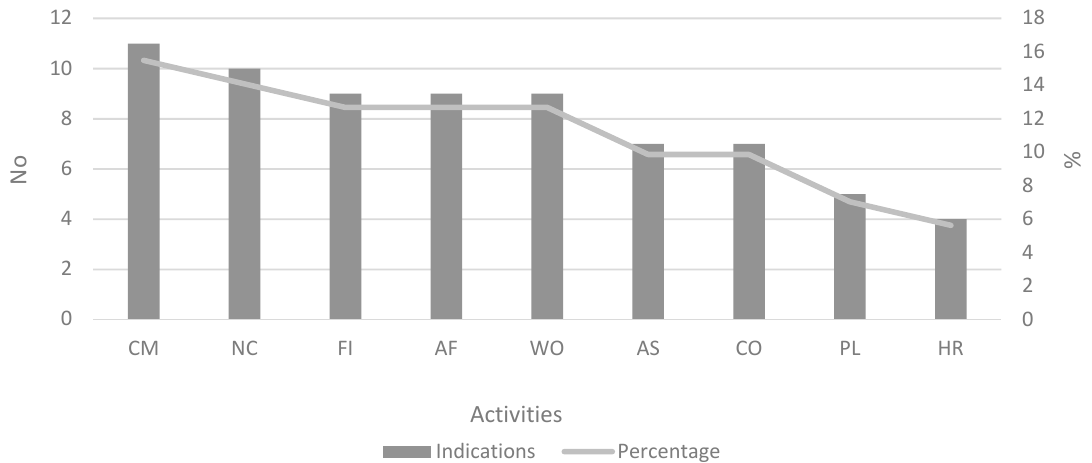
Figure 3. The areas of activity undertaken by RNPOs under the uncertainty conditions of the COVID-19 pandemic. Notes: CM—crisis management; FI—finance; AF—activity forms; AS—activity scopes; CO—cooperation; HR—human resources; WO—work organisation; PL—planning; NC—no change. Source: authors’ survey. Table 5. Statistically significant Spearman’s rank correlation coefficients ( ρ S ) and determination coef- ficients ( R 2 in %) matrix between levels of organisational resilience (OR) in the areas of undertaken activities.